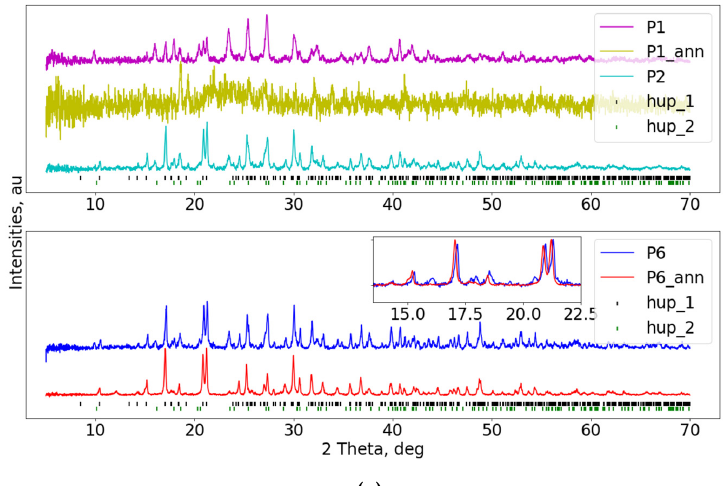
Figure 3. ( a ) PXRD patterns of the: As1 (90% Gm and 10% HUAs), As2 (80% Gm and 20% HUAs) and As6 (40% Gm and 60% HUAs) composites inset on an upper sub-figure shows reflection’s shift towards higher angles, indicating shrinkage of the material’s unit cell. ( b ) the As4 (54% Gm and 46% HUAs) and As8 (18% Gm and 82% HUAs) HUAs-based composites. Vertical bars show Bragg peak positions of the assigned crystallographic phases (see main